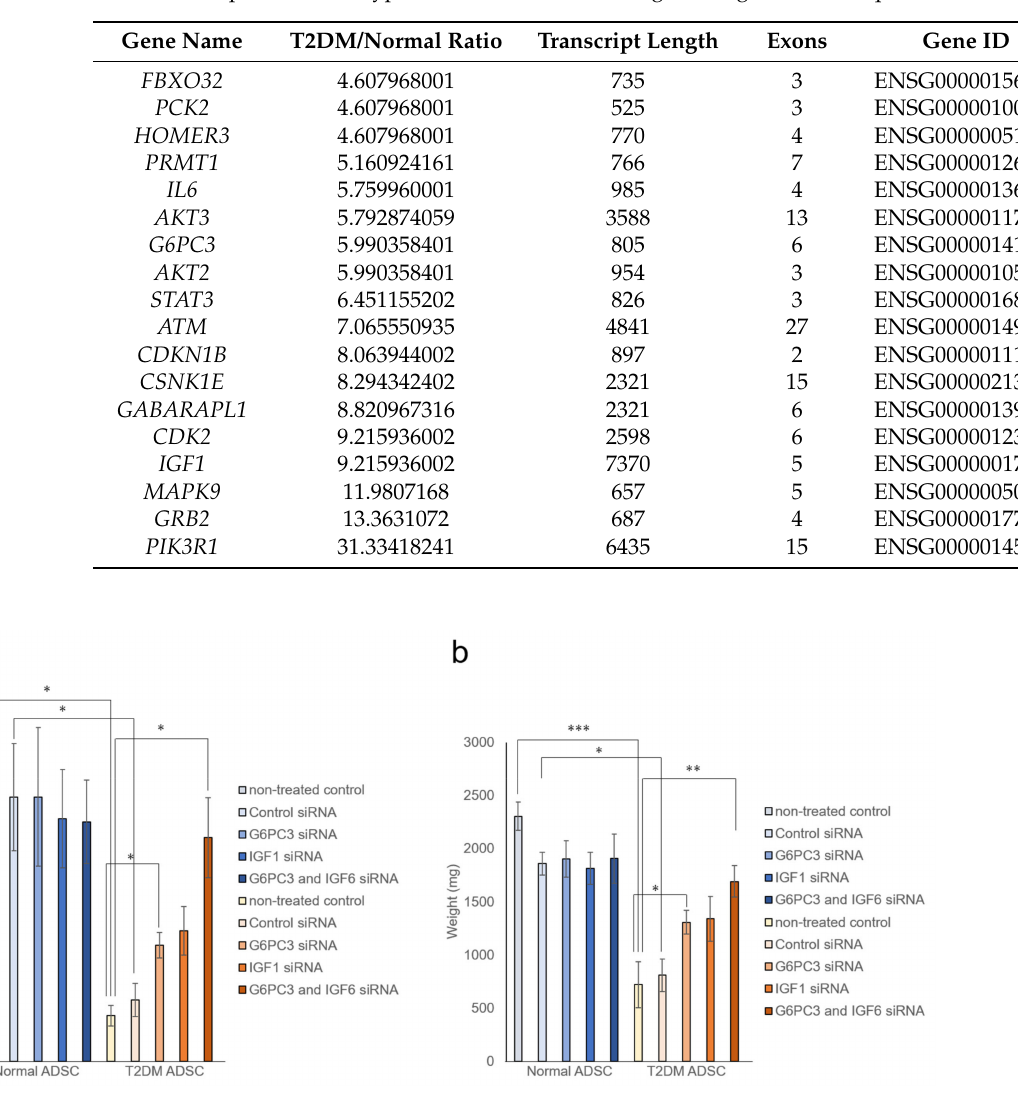
Table 2. Listing of differentially expressed genes related to the FoxO signaling pathway in ADSCs derived from patients with type II diabetes mellitus using a next-generation sequencer.